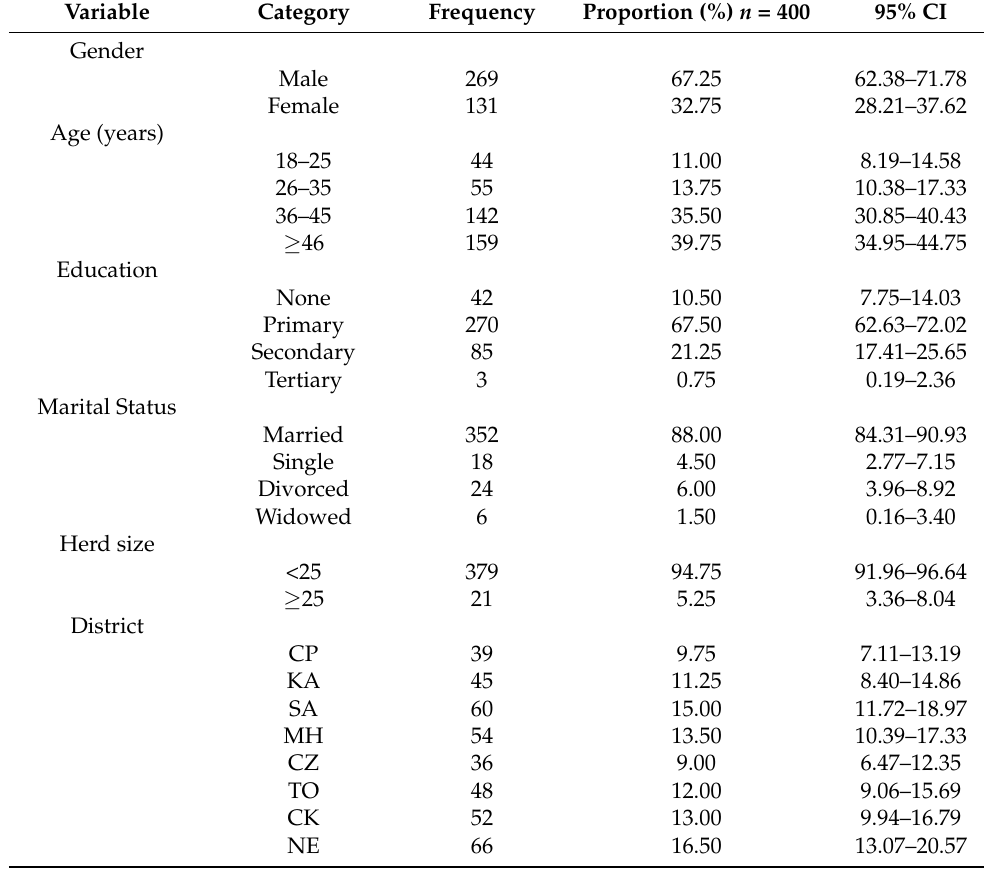
Table 1. Summary of socio-demographic